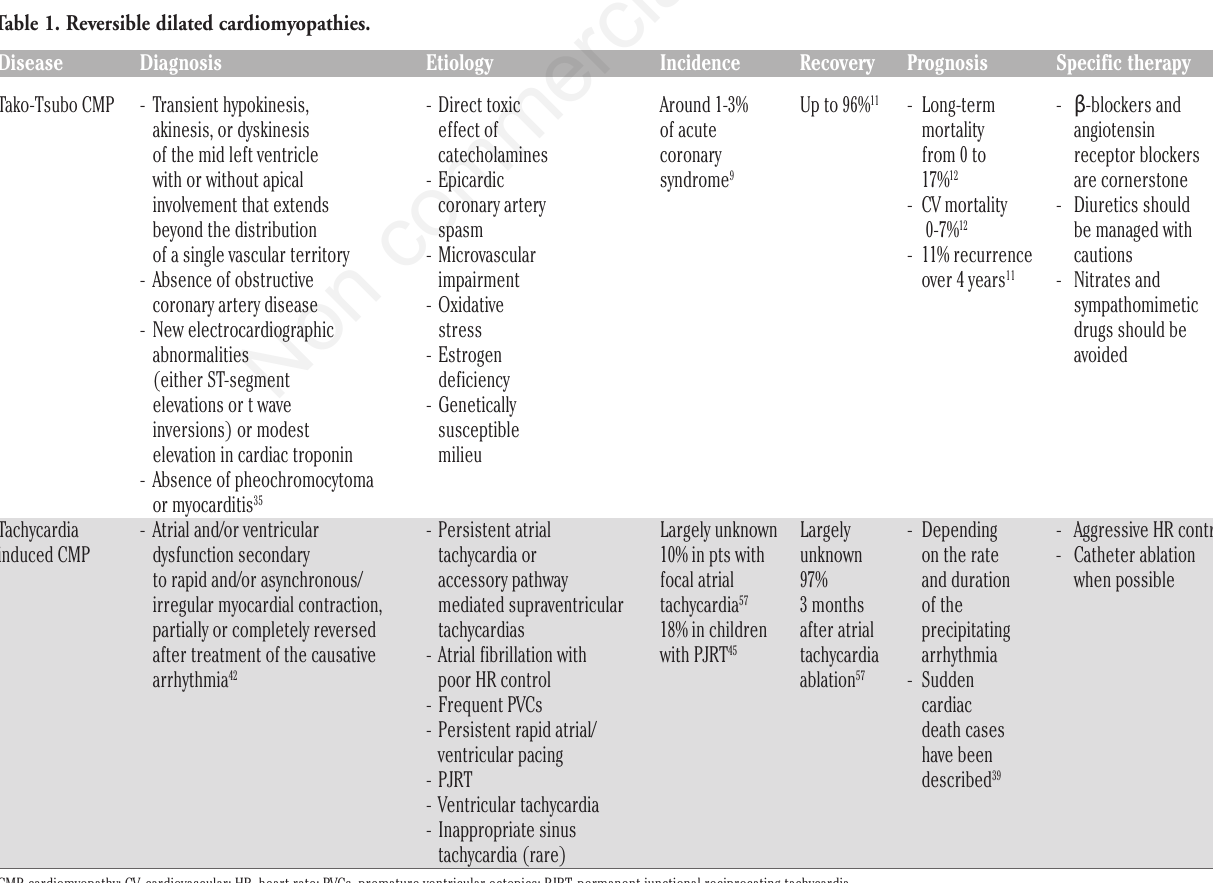
Table 1. Reversible dilated cardiomyopathies.